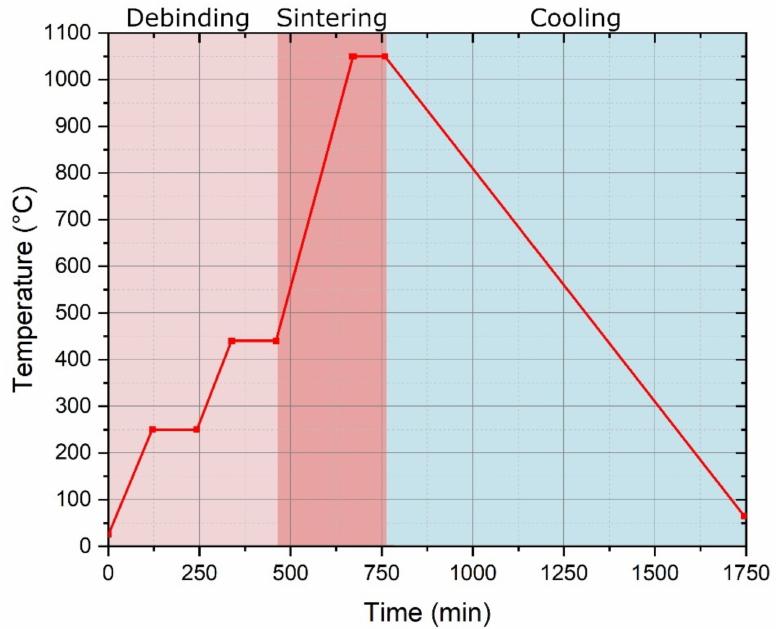
Figure 3. Thermal debinding and sintering profile. All heating rates were 2 K/min. 1 h debinding plateaus at 250 and 450 ◦ C and 1 h sintering plateau at 1050 ◦ C were used.